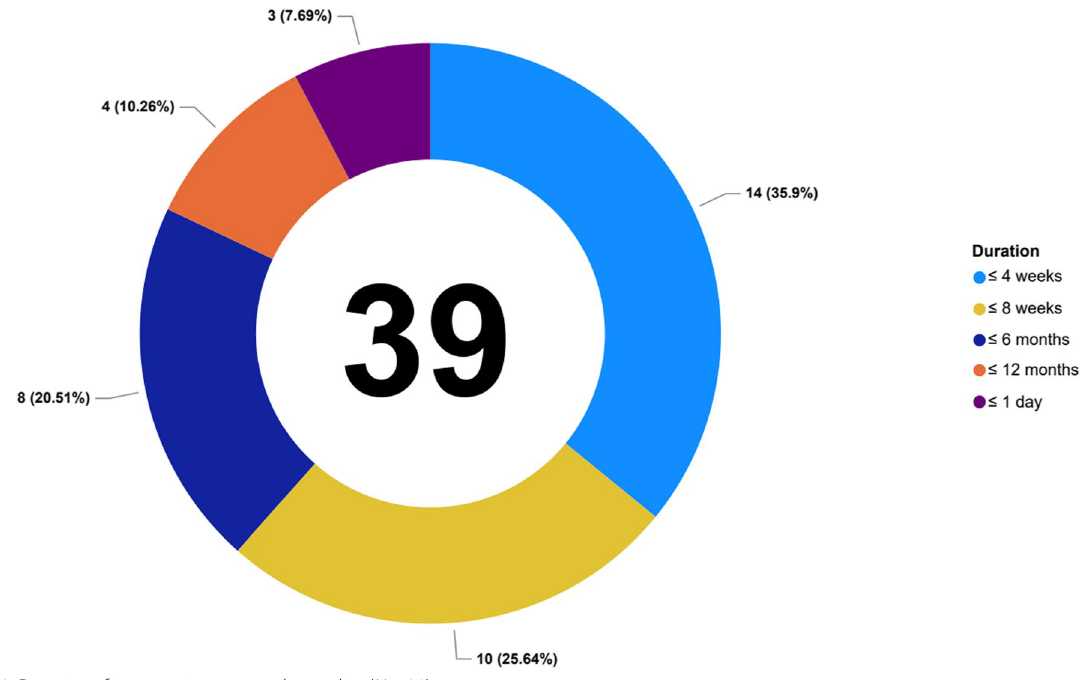
Fig. 6 Duration of interventions across the studies ( N